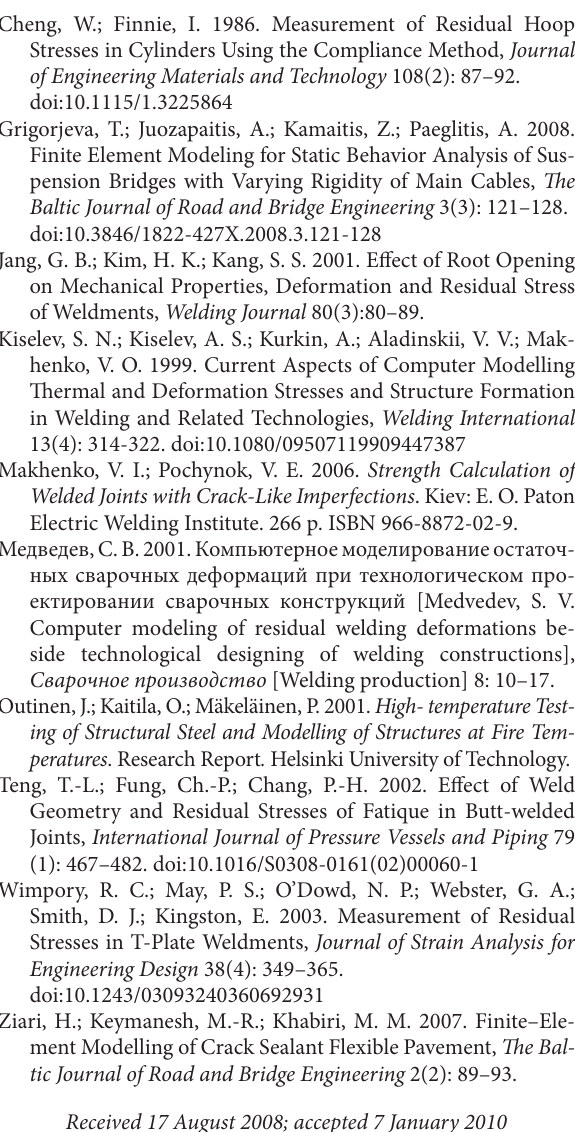
Fig. 17. Main residual stress s corner view, MPa